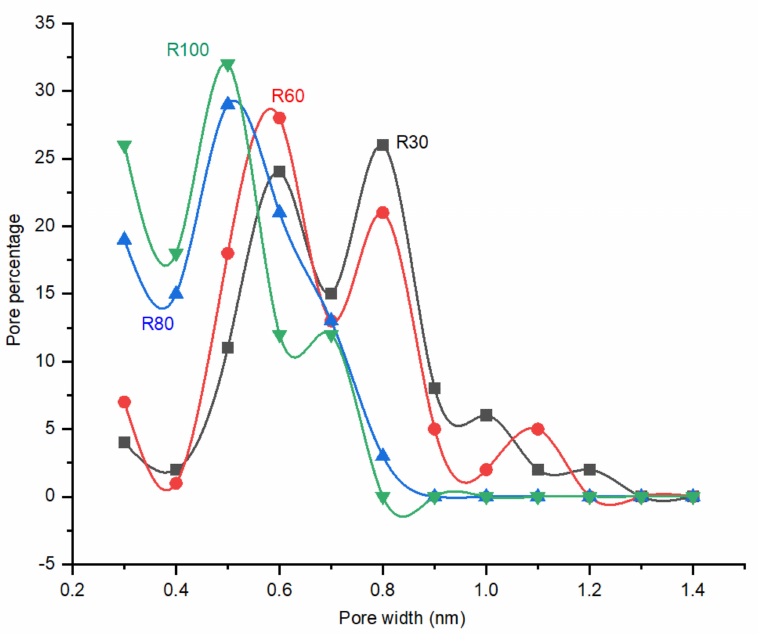
Figure 7. Effect of temperature on the PSD (Pore Size Distribution) of the CMSMs (Carbon Molecular Sieve Membranes) polymerized at various